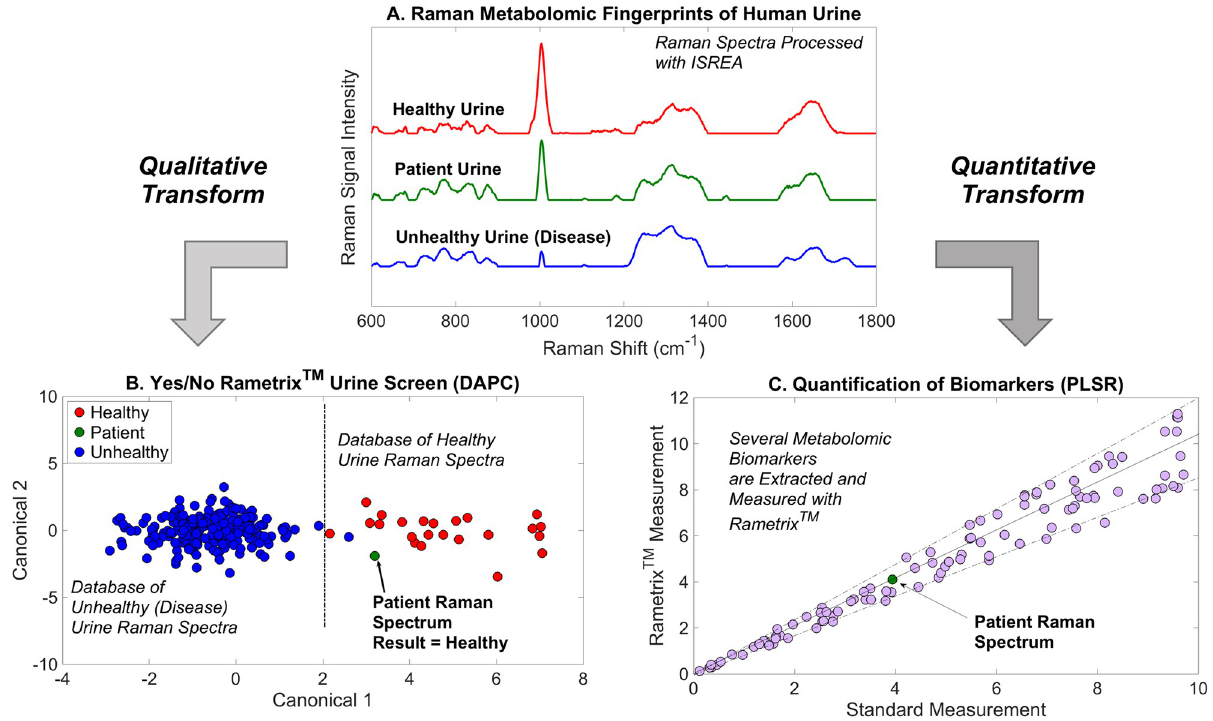
Fig 1. Schematic of qualitative and quantitative chemometric analyses of urine spectra using the Rametrix 1 Toolbox.